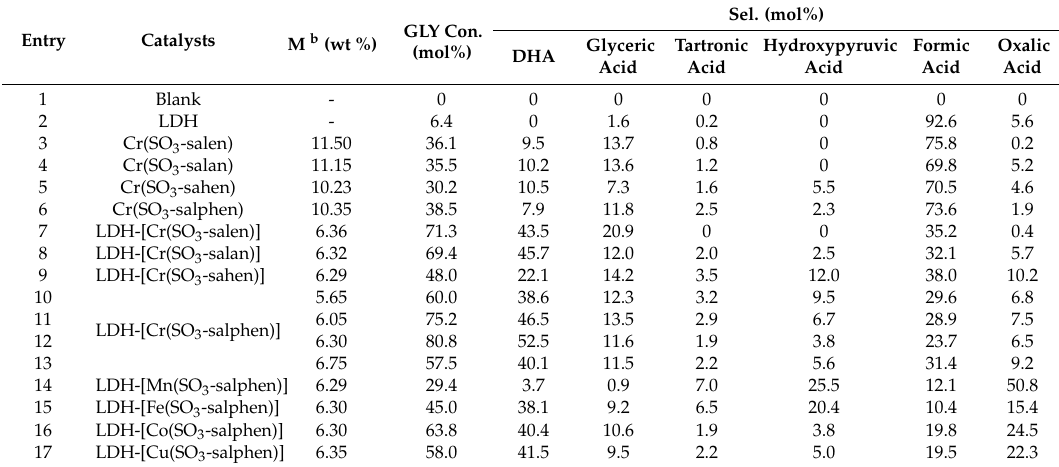
Table 2. Catalytic performance of catalysts in GLY (glycerol) oxidation with 3% H 2 O 2 a